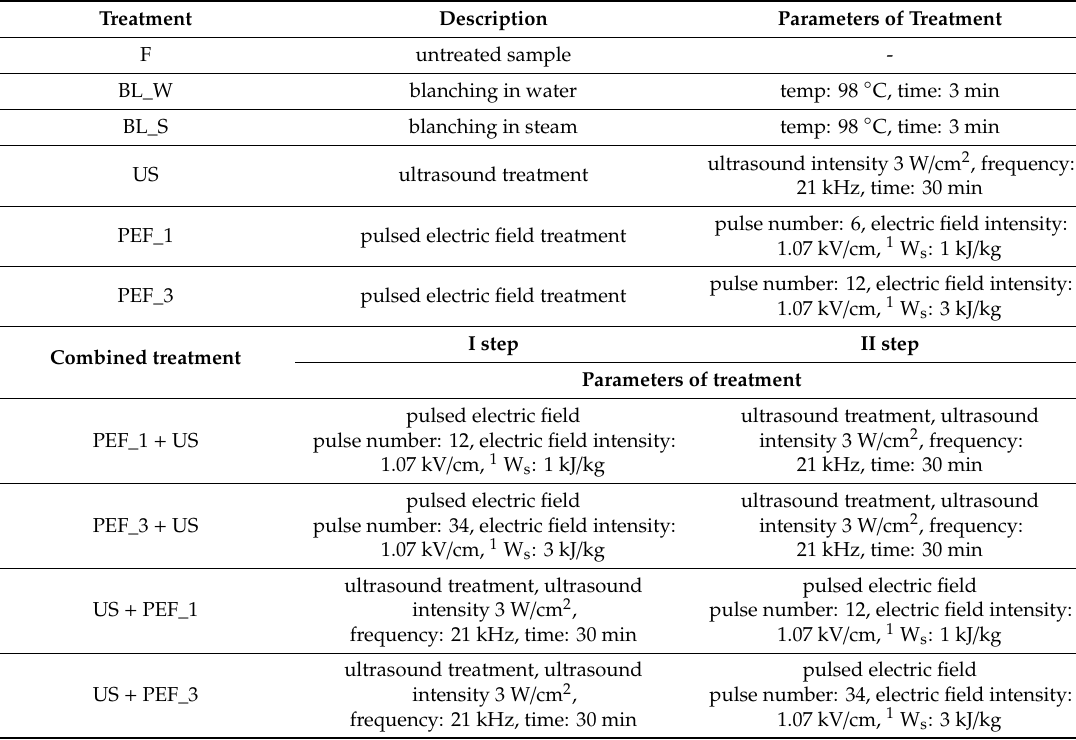
Table 2. Abbreviations and parameters of conducted treatment for red bell